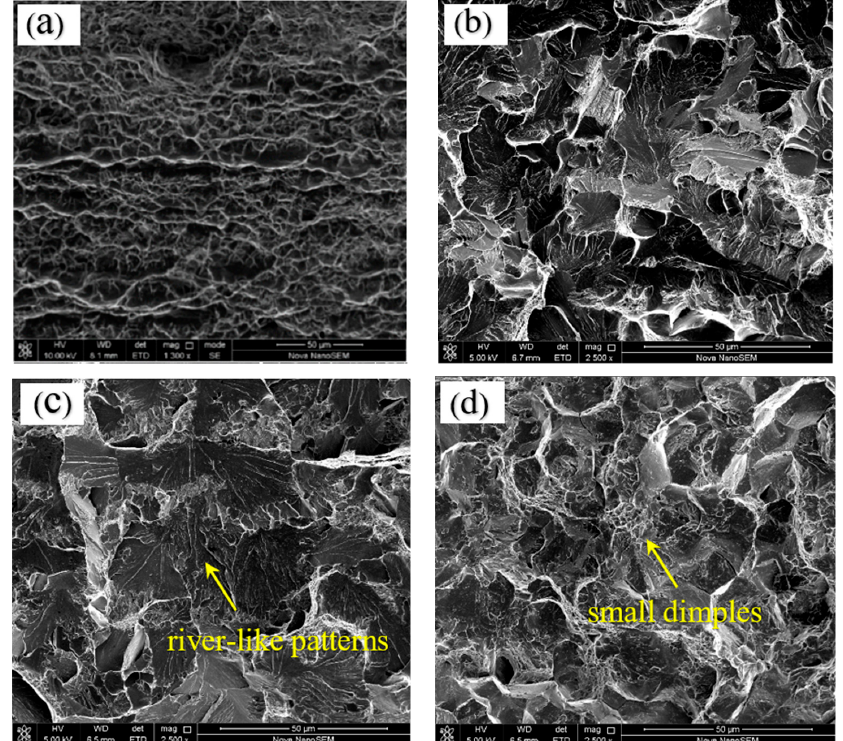
Figure 16. fracture of tensile specimen: ( a ) TC4 substrate; ( b ) top of the weld, ( c ) middle of the weld, ( d ) bottom of the weld. ( d ) bottom of the